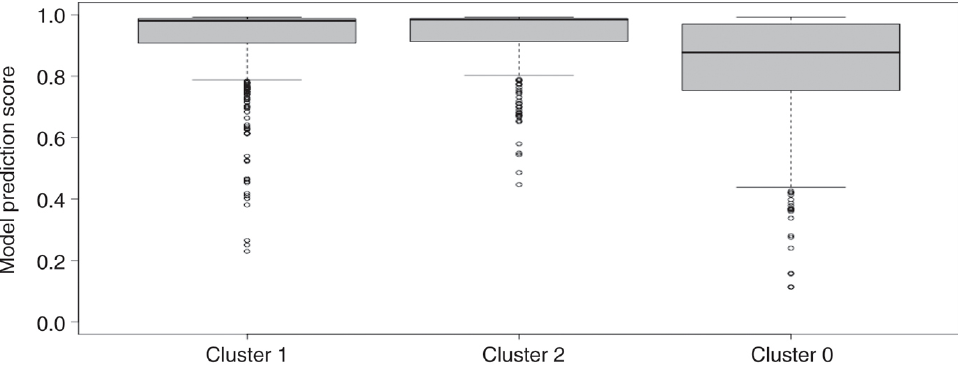
Figure 9: Performance of clusters in MirGeneDB data. Overall Cluster 0 has 402 hairpins, Cluster 1 has 563 hairpins and Cluster 2 has 469 hairpins. Cluster 0: Minimum 0.113, Lower whisker 0.438, Lower quartile 0.753, Median 0.877, Upper quartile 0.971, Upper Whisker 0.992, Maximum: 0.992; Cluster 1: Minimum 0.230, Lower whisker 0.788, Lower quar- tile 0.908, Median 0.980, Upper quartile 0.988, Upper Whisker 0.992, Maximum:0.992; Cluster 2: Minimum 0.447, Lower whisker 0.802, Lower quartile 0.913, Median 0.985, Upper quartile 0.988, Upper Whisker 0.992,